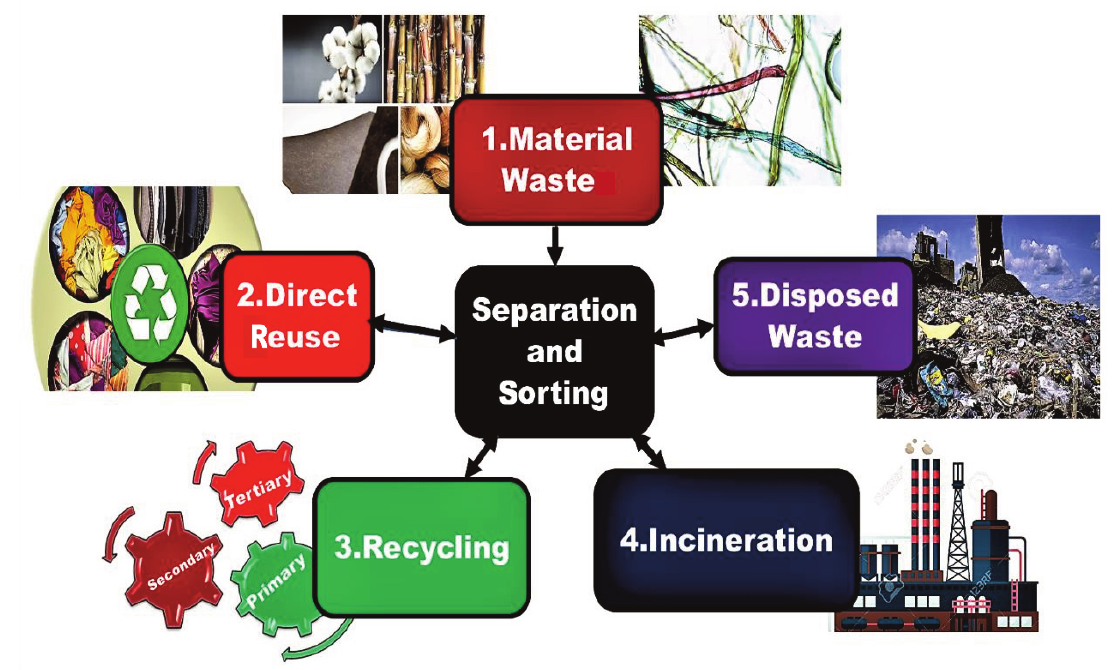
Fig. 5. Proposed JIT model for textile waste